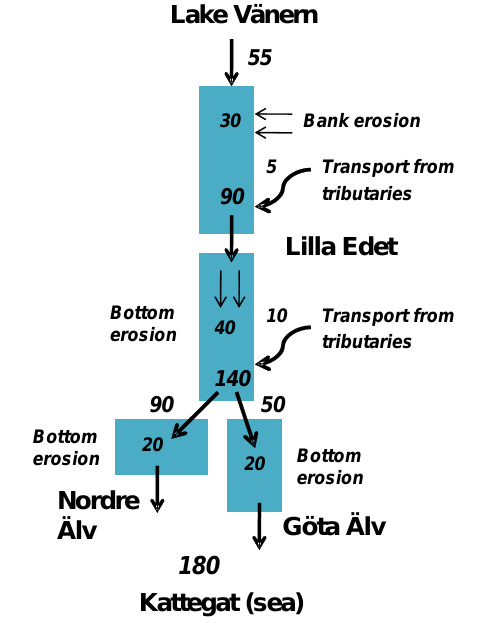
Fig. 1. The G¨ota ¨Alv catchment (left panel) and its section from Lake V¨anern to the Kattegatt sea, with seven stations for water qual- ity monitoring and the outlets from three main tributaries shown (right panel). (Background map © Lantm¨ateriet, data from Swedish Meteorological and Hydrological Institute.)